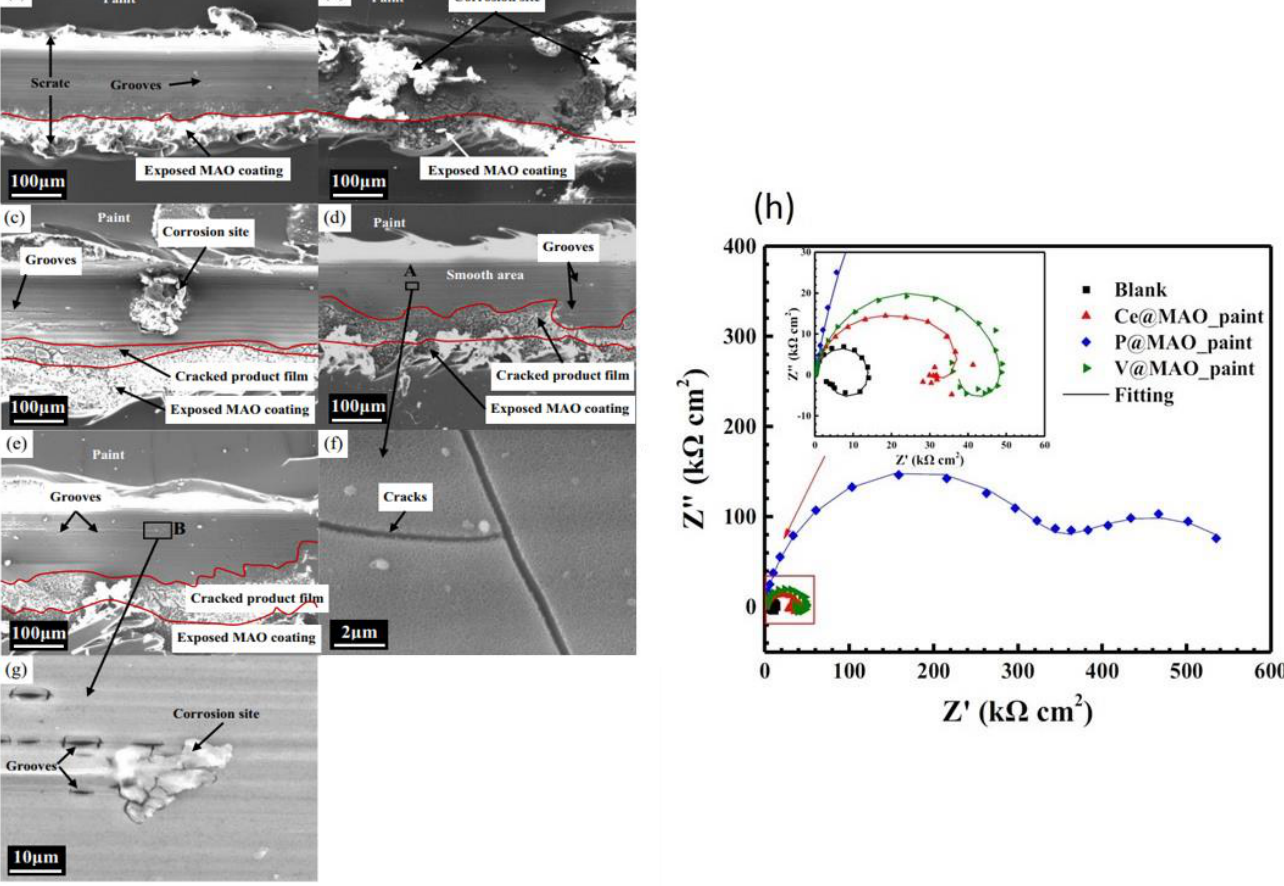
Figure 24. ( a ) SEM micrographs of the scratched areas of a PEO coating on AM60 alloy sealed with a water-based paint; ( b ) after immersion in 3.5 wt.% NaCl for 24 h ( c ) with Ce(NO 3 ) 3 , ( d , f ) with Na 3 PO 4 , ( e , g ) with NaVO 3 . ( h ) EIS spectra of the scratched composite coatings after immersion in 3.5 wt.% NaCl for 24 h. Adapted from [256] with permission from ECS.